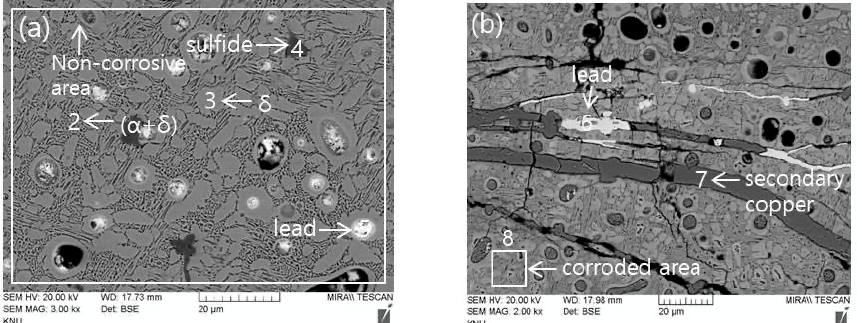
Figure 9. Ga-35 (No. 3) scanning electron microscope-energy dispersive spectrometer (SEM-EDS) images that show an uncorroded microstructure ( a ) and a line composed of secondary copper in the corroded microstructure ( b ). Table 3. Ga-35 (No. 3) microstructure energy dispersive spectrometer (EDS) results.